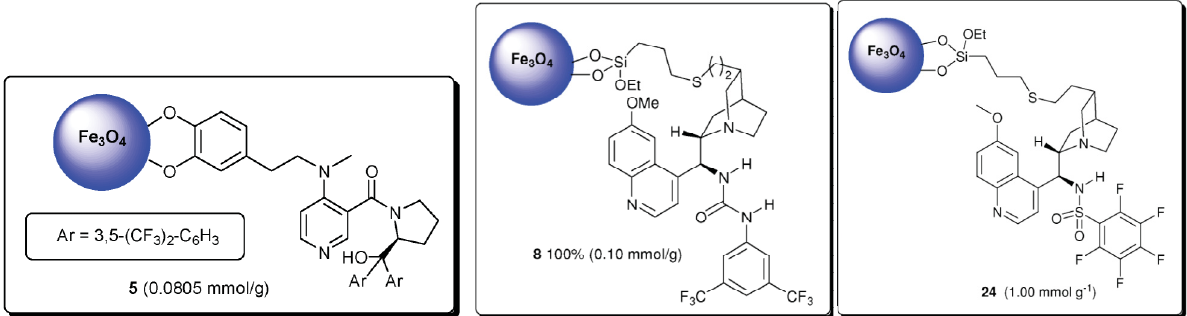
Figure 10. Bifunctional catalysts directly immobilised on magnetite nanoparticles. Reproduced from Gleeson et al. [75] with permission of the Royal Society of